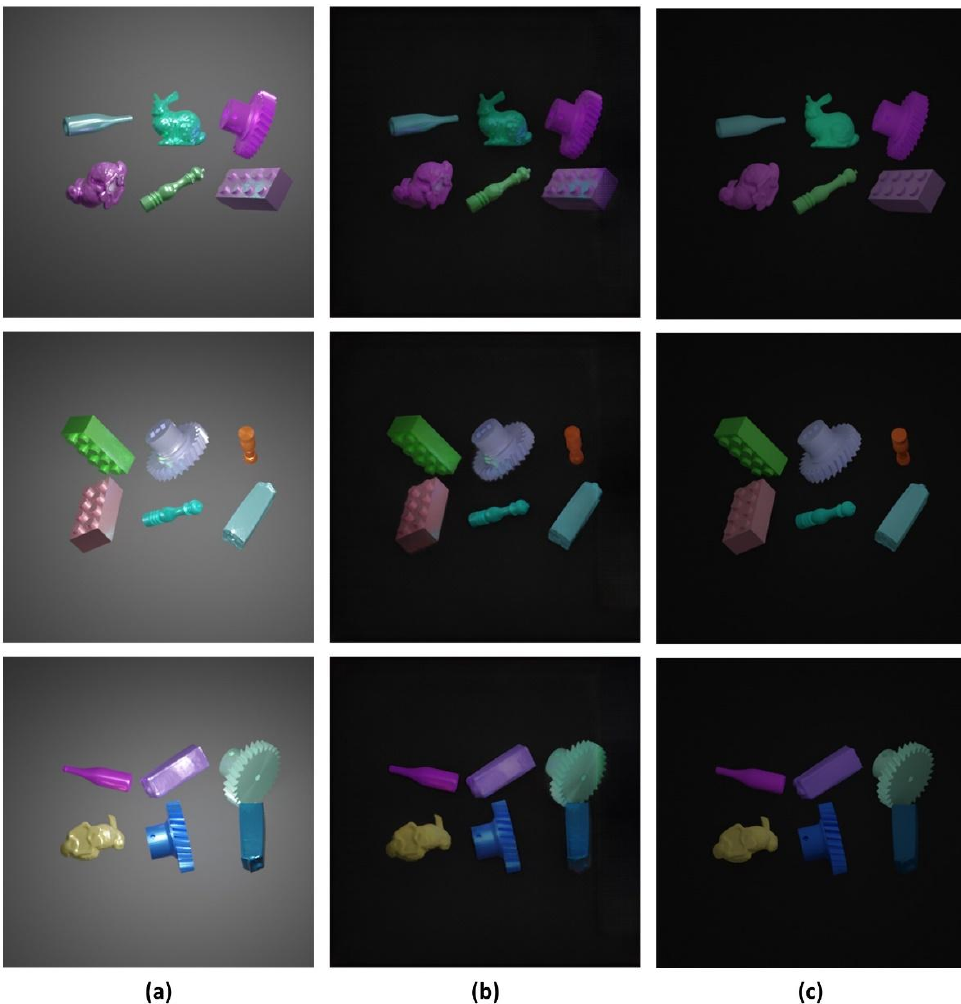
Figure 16. The output comparison of proposed SpecToPoseNet . ( a ) Input images with specular reflections; ( b ) Output images generated from specular reflection remover of SpecToPoseNet ; ( c ) Diffuse target images.